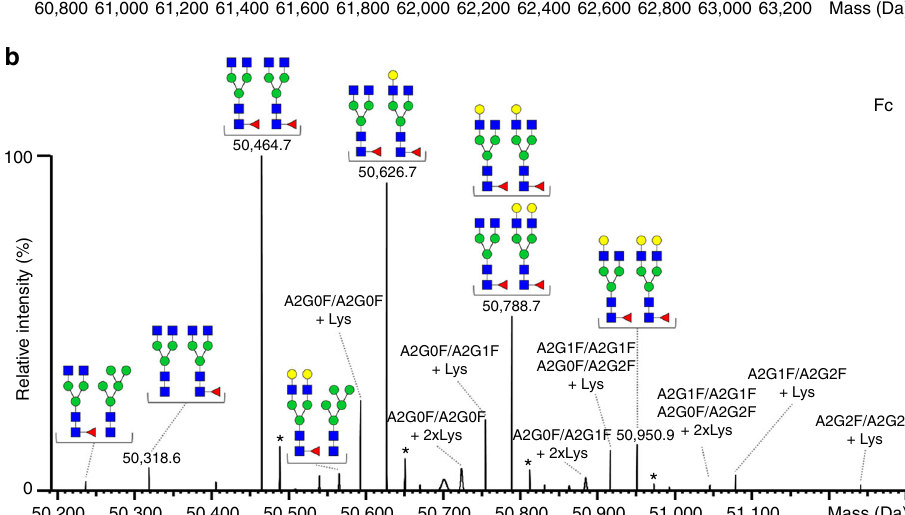
Fig. 3 N -glycosylation of Etanercept TNFR and Fc domains. a Deconvoluted spectrum of dimeric TNFR digested with sialidase and O -glycosidase acquired under native conditions (raw spectrum shown in Supplementary Fig. 6c, d). The most probable glycan structures lacking sialic acids are annotated. b Deconvoluted spectrum of Fc dimer upon native MS (raw spectrum shown in Supplementary Fig. 7). The most probable N -glycoforms and C-terminal lysine variants are annotated. Asterisks indicate Na + adducts. Peak lists with all possible glycoform assignments are available in Supplementary Data